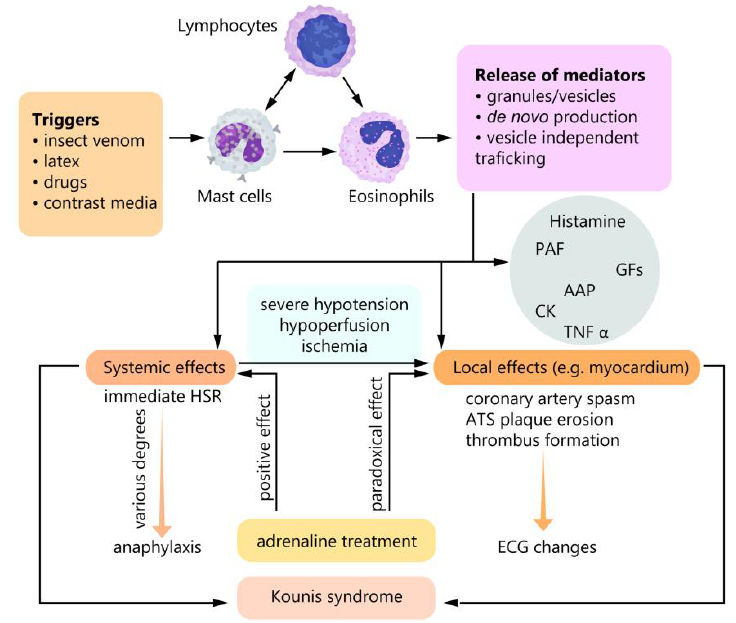
Figure 1. Kounis syndrome pathophysiology. The inflammatory cascade induced by triggers, through activation of mast cells, lymphocytes, and eosinophils, leads to systemic and local effects. The systemic effects have a potential impact on the myocardial tissue through hypotension, resulting in hypoperfusion and subsequent ischemia. Adrenaline can control the systemic response but has a paradoxical effect in the myocardial tissue (favorizes thrombus formation). Both the local and systemic effects can play a role in the generation Kounis syndrome. Arachidonic acid products (AAP), atherosclerotic (ATS), cytokines (CK), growth factors (GFs), hypersensitivity reaction (HSR) [12], platelet-activating factor (PAF).